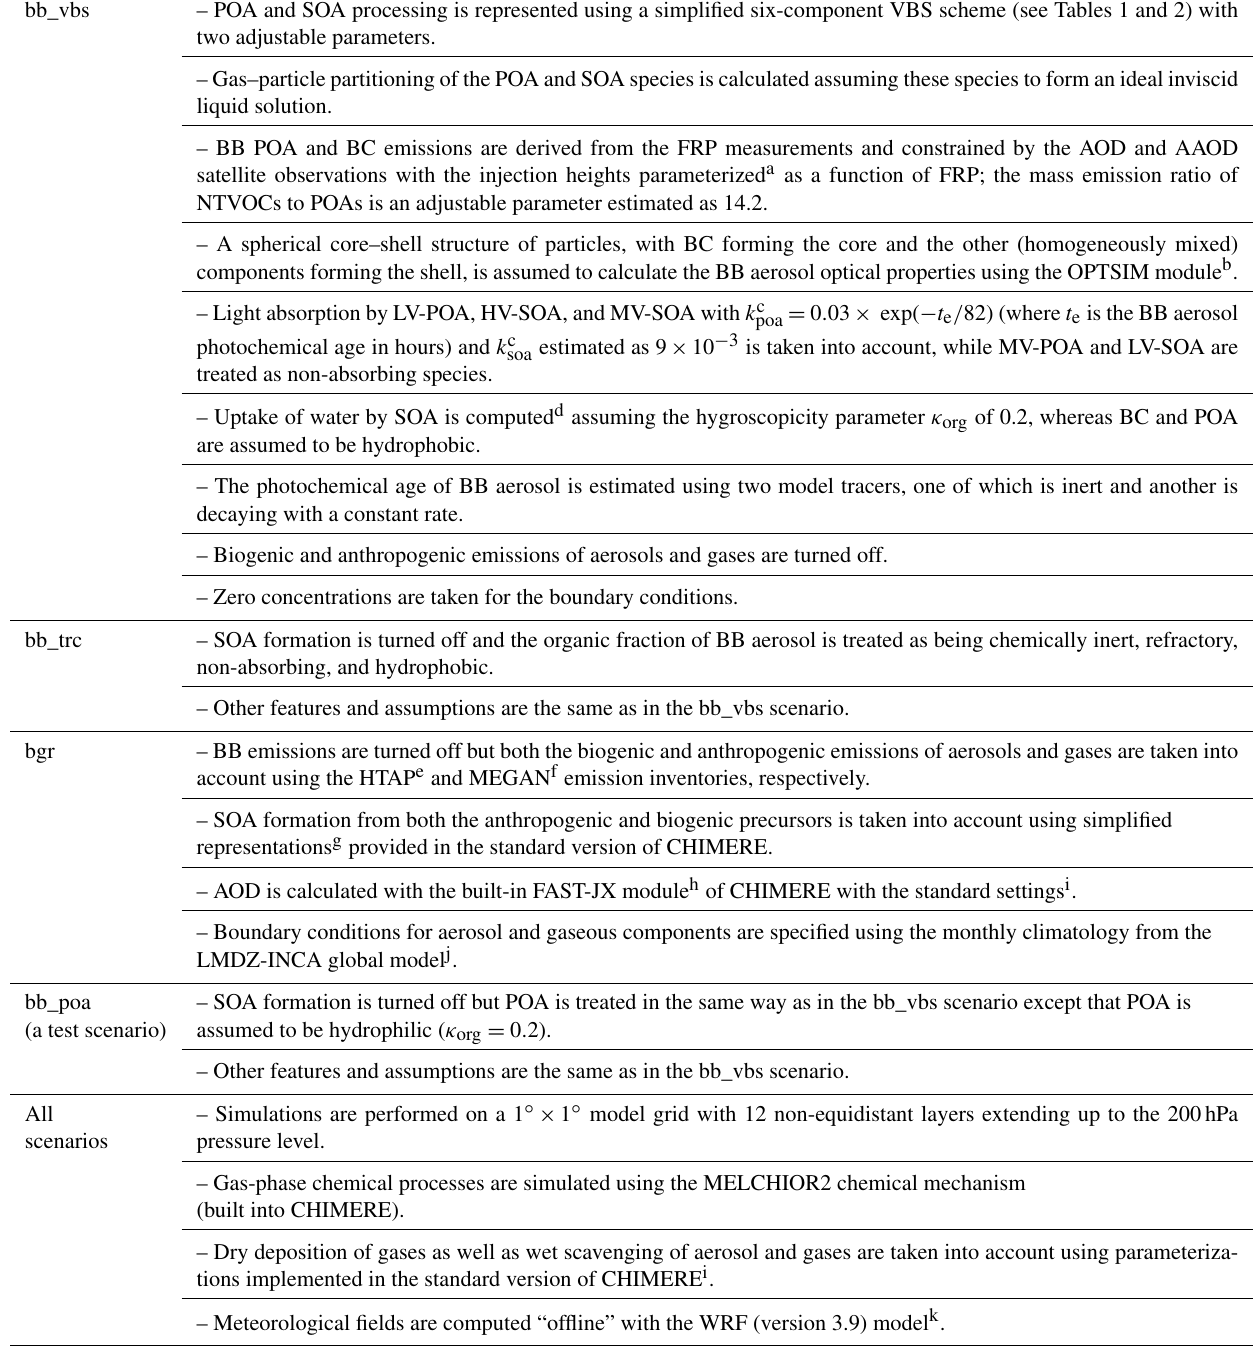
Table 3. Key features of the configuration of the simulations with the CHIMERE